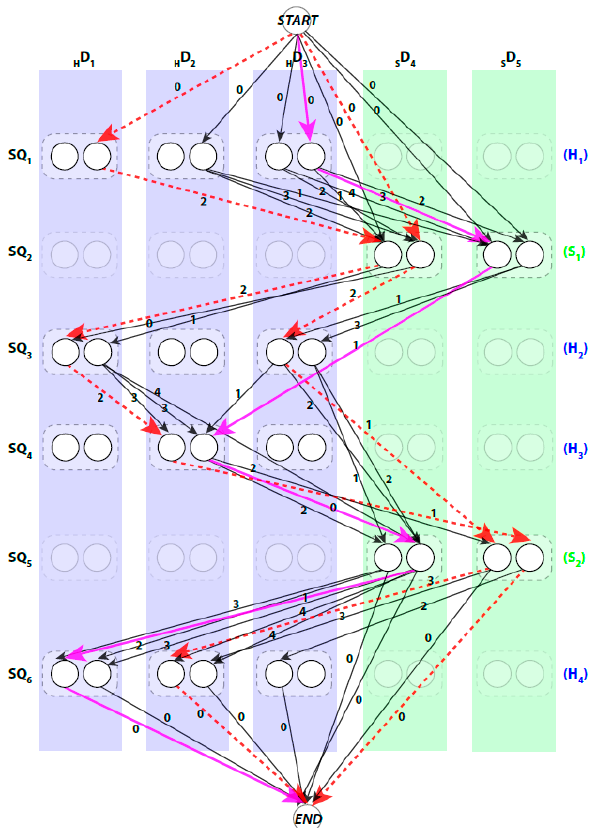
Figure 2. An example of a topology graph. The weights were restricted to integers to save the space in drawing. Two examples of invalid paths are shown in red dashed lines. The shortest path is shown in magenta solid lines. The transparent nodes are nodes that are invalid where the sequence segment is assigned to a stick of different type. Only possible edges are shown.